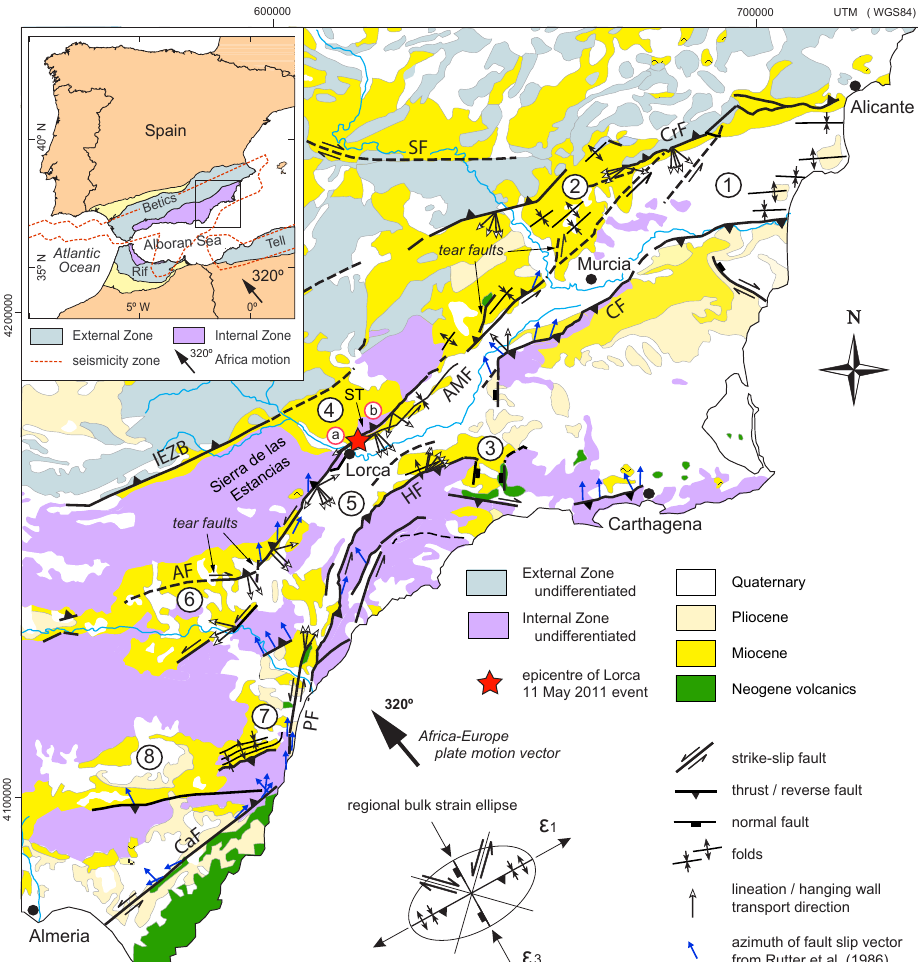
Fig. 1. Geological and structural-tectonic sketch map of SE Spain between Alicante and Almer´ıa showing the main Alhama de Murcia – Crevillente fault belt, compiled after Meijninger and Vissers (2006). Numbers in circles refer to Neogene basins: (1) Alicante-Bajo Segura basin, (2) Fortuna basin, (3) Mazarr´on basin, (4) Lorca basin, (5) Guadalentin-Hinojar basin, (6) Huercal Overa (Albox) basin, (7) Vera basin, (8) Sorbas-Tabernas basin. Abbreviations: AF Albox fault, AMF Alhama de Murcia fault, CaF Carboneras fault, CF Carrascoy fault, CrF Crevillente fault, HF Hinojar Fault, IEZB Internal-External Zone Boundary (or North Betic Fault), PF Palomares fault, SF Socovos fault, ST Sierra de la Tercia. Seismic zone in inset after Buforn et al. (1988). Slip vectors from Meijninger (2006) and Meijninger and Vissers (2006) represent either group averages or single measurements, based on striations on fault surfaces and shear planes in fault gouges, or movement directions determined from Riedel shear and P-foliation geometries in fault gouges. The data are supplemented with azimuths of fault slip vectors from Rutter et al. (1986). Roman letters a and b in circles near Lorca refer to fault exposures illustrated in stereographic projections of Fig. 2. Regional bulk strain ellipse based on structural data and fault-plane solutions from Jimenez-Munt et al. (2001), Stich et al. (2003) and Buforn et al. (2004). African-European plate motion vector from DeMets et al.